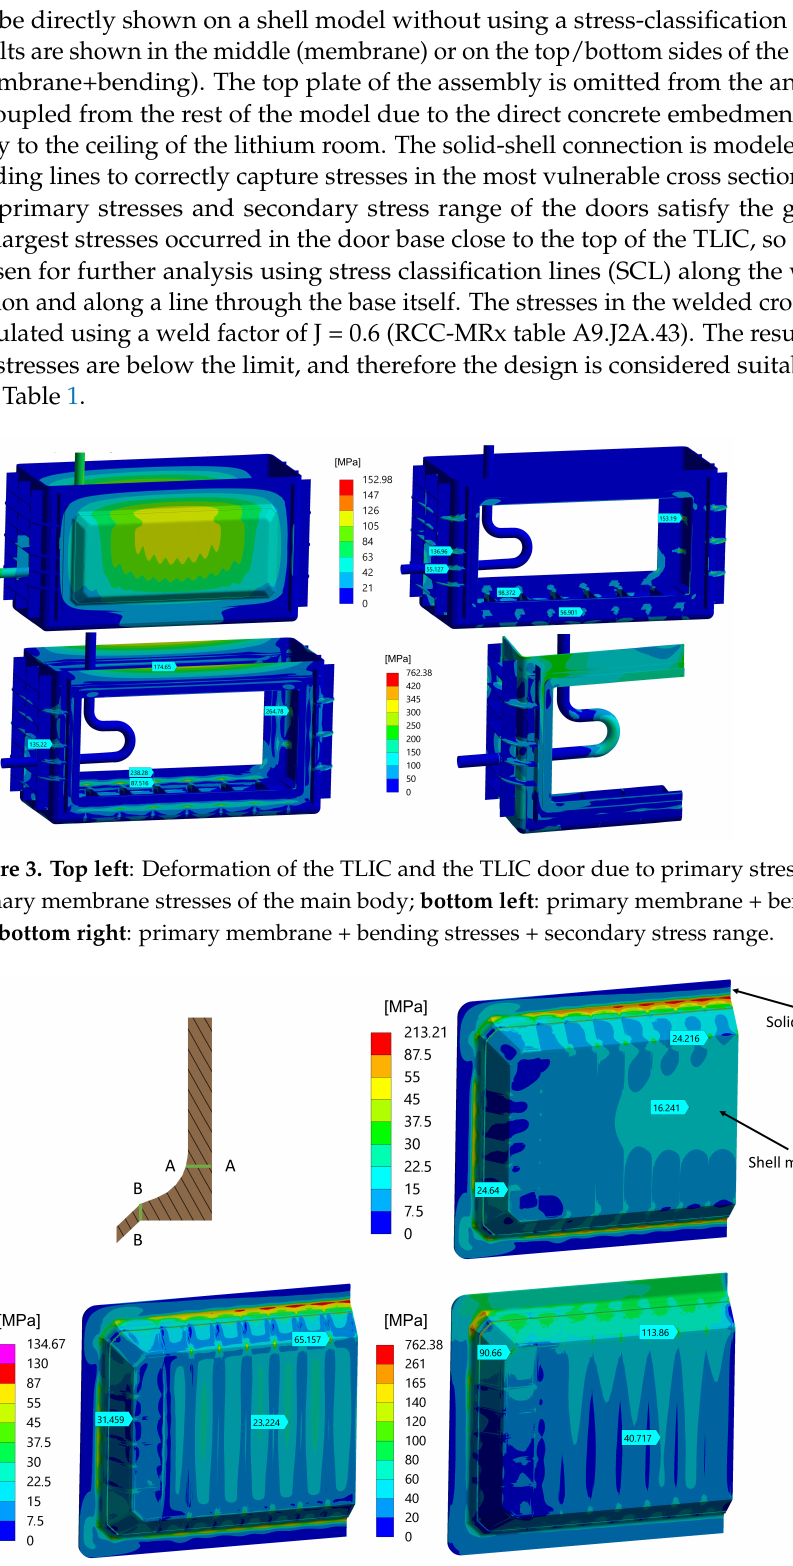
Figure 4. P-type and S-type damage evaluation of the TLIC door. Top left : SCL line definition in the solid door base; top right : primary membrane stresses; bottom left : primary membrane + bending stresses; and bottom right : primary membrane + bending stresses + secondary stress